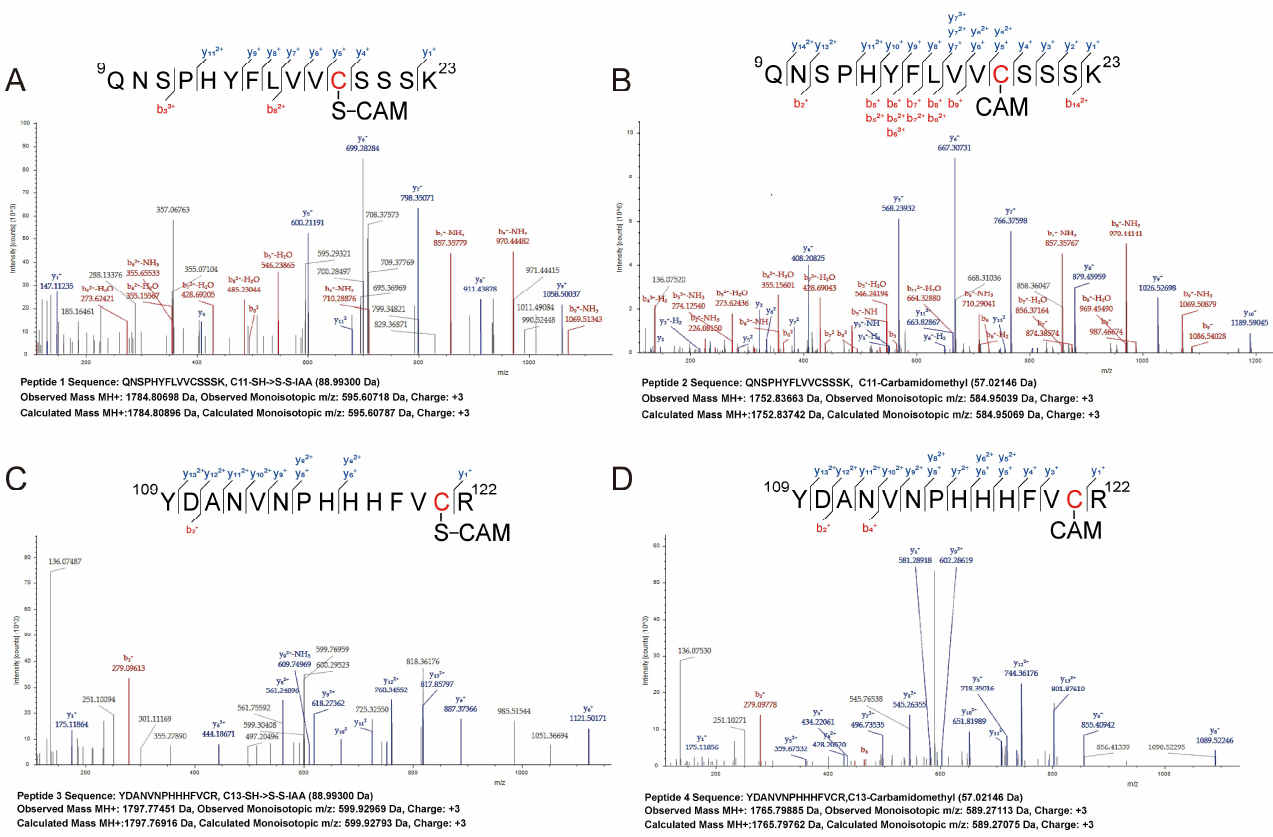
Figure 5. H 2 S n acted on the cysteines of PerR. ( A ) The Cys 19 –SSH group was blocked by IAM in the peptide 1 from H 2 S n –treated PerR. ( B ) The Cys 19 –SH group was blocked by IAM in the peptide 2 from DTT-treated PerR. ( C ) The Cys 121 –SSH group was blocked by IAM in the peptide 3 from H 2 S n -treated PerR. ( D ) The Cys 121 –SH group was blocked by IAM in the peptide 4 from DTT–treated PerR. The purified PerR (5 mg/mL) was treated with 1 mM H 2 S n and 1 mM DTT for 30 min, at 25 °C. After denaturing and incubating with IAM, the reacted protein was digested by trypsin. The generated peptides were detected by LTQ-Orbitrap tandem mass spectrometry.